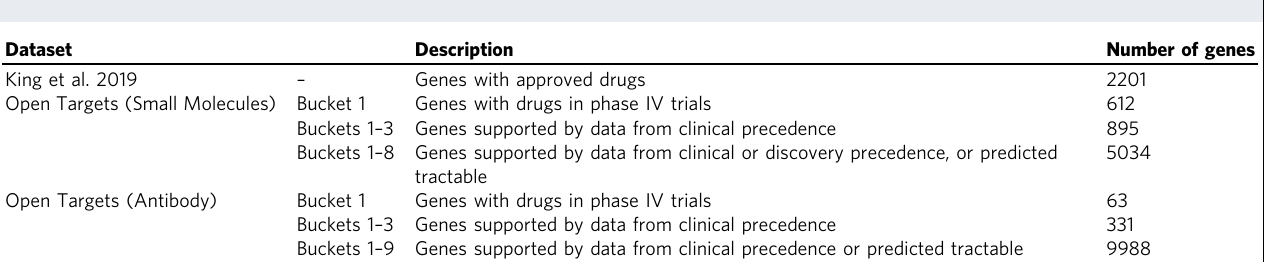
Table 3 Validation